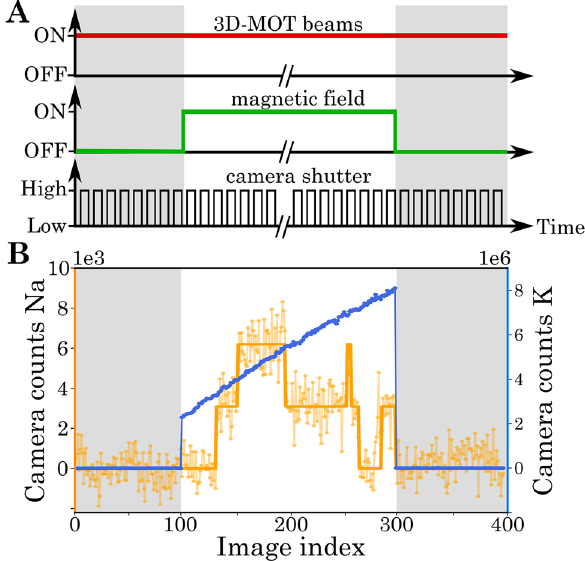
Figure 4. Experimental sequence. A: A series of images (black) is taken. While the MOT beams (red) are always on, the magnetic field (green) is switched off for reference images marked in grey. B: Typical time trace from the series of images of sodium (orange) and potassium